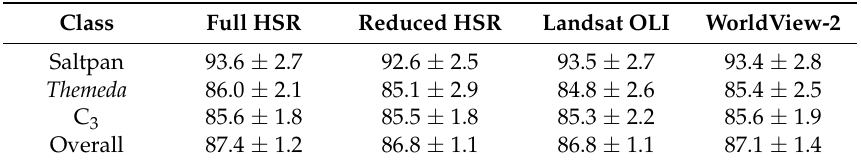
Table 4. Average RF classification accuracy and standard deviations for all three-class results, as averaged across the 30 RF classifications. Accuracies are presented as mean percentages, while standard deviation is presented as a percentage range above or below the mean.